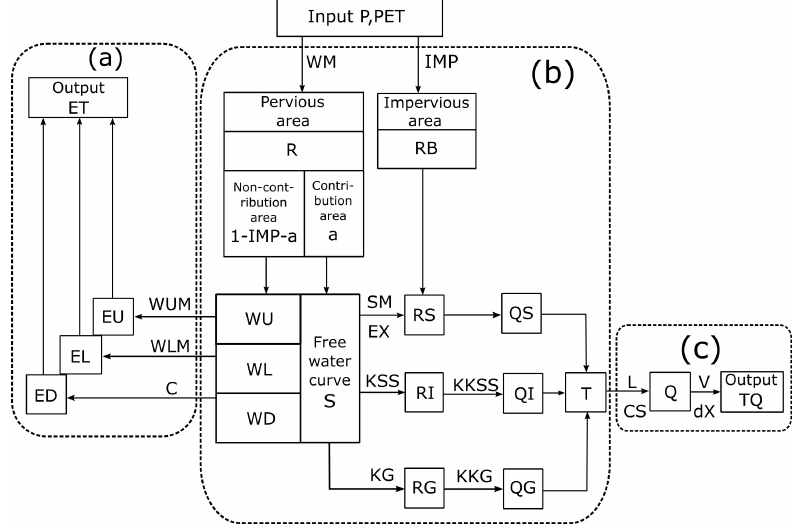
Figure 2. Adopted flowchart of the XAJ model (Zhao, 1992). The model consists of an evapotranspiration component (a) , a runoff generating component (b) , and a runoff routing component (c) . P, PET, and ET are the precipitation, potential evapotranspiration, and the simulated actual evapotranspiration respectively; WU, WL and WD represent the upper, lower, and deep soil layers’ areal mean-tension water storage respectively; WM is the areal mean field capacity; EU, EL, and ED stand for the upper, lower, and deep soil layers’ evapotranspiration output respectively; S is the areal mean free water storage; a is the portion of the sub-catchment producing runoff; IMP is the factor of impervious area in a catchment; RB is the direct runoff produced from the small portion of impervious area; R is the total runoff generated from the model with surface runoff (RS), interflow (RI), and groundwater runoff (RG) components respectively. These three runoff components are then transferred into QS, QI, and QG and combined as the total sub-catchment inflow (T) to the channel network. The flow outputs Q from each sub-catchment are then routed to the catchment outlet to produce the final flow result (TQ). The rest of the symbols are explained in